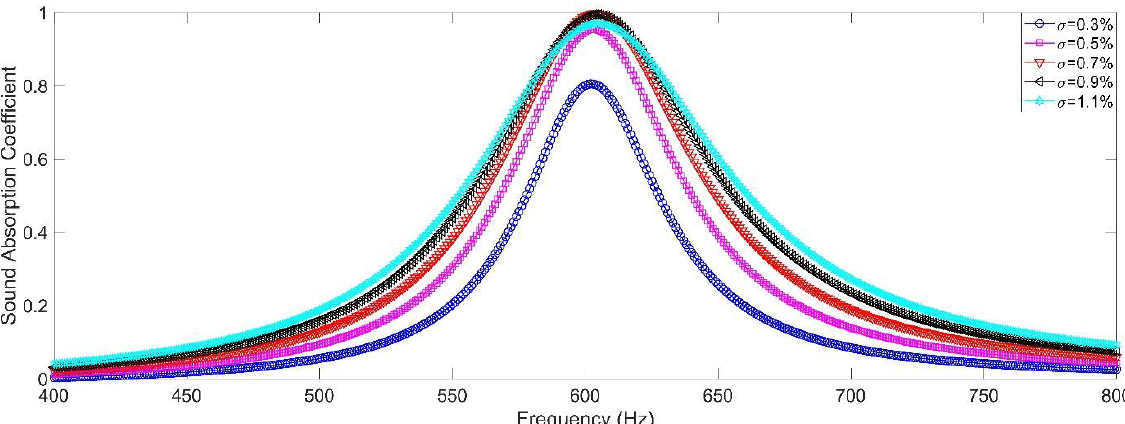
Figure 3. The influence of the perforation ratio to sound absorption performance of the double resonators in simulation.